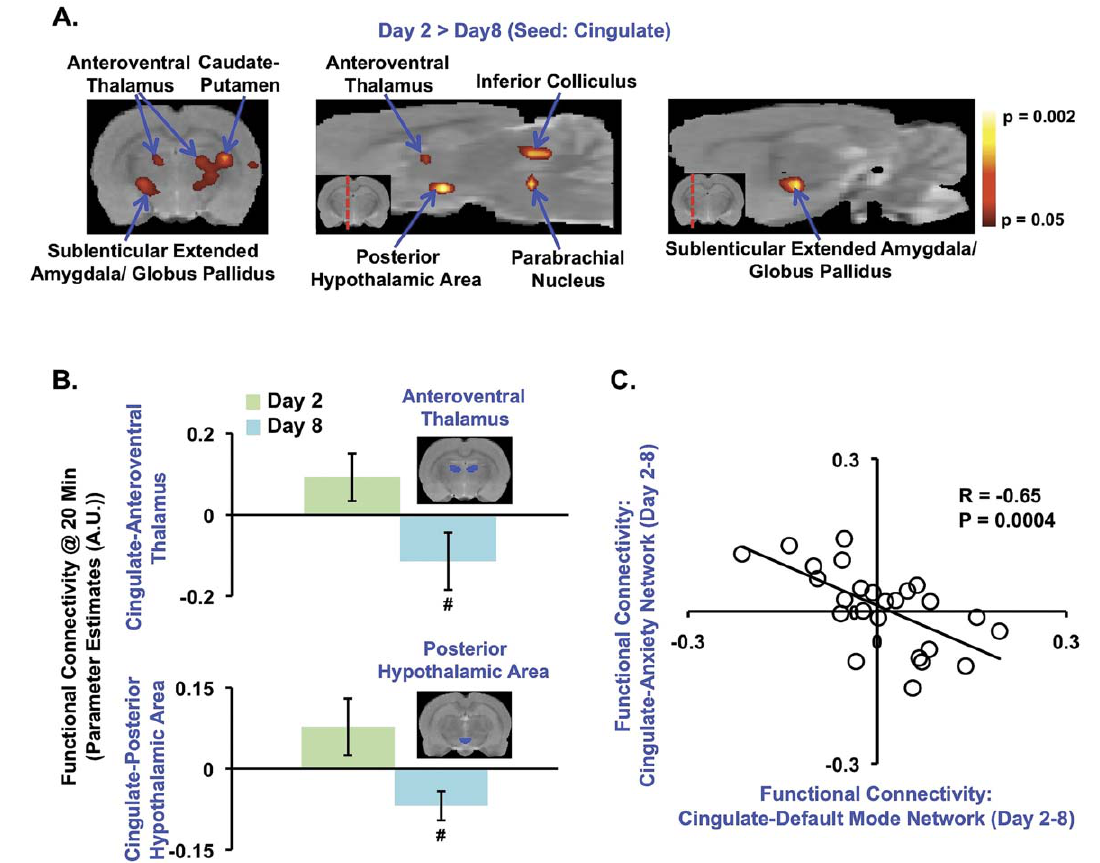
Figure 3. Functional Connectivity in the Anxiety Network in Non-habituated, Awake Rats. A-B. Functional connectivity amongst the anterior cingulate cortex and brain regions implicated in anxiety was significantly greater during the initial scanning session at Day 2. All statistical maps are superimposed upon an in-house, high-resolution rat anatomical template. B. Functional connectivity at Day 2 and Day 8 is quantified between the cingulate and anteroventral thalamus, and also with the posterior hypothalamic area. The ANOVA test yielded insignificant results for the cingulate-anteroventral thalamus (F 3,22 =2.49, p=0.087) and cingulate-posterior hypothalamic area (F 3,22 =1.37, p=0.27) functional interactions. Two-tailed, t-test did reveal significant differences particularly between Day 2 and Day 8 (cingulate-anteroventral thalamus- Day 4 : t 10 =1.91, p=0.09; Day 6 : t 12 =1.31, p=0.22; Day 8 : t 12 =2.26, p=0.043). (cingulate-posterior hypothalamic area- Day 4 : t 10 =1.07, p=0.30; Day 6 : t 12 =0.52, p=0.61; Day 8 : t 12 =2.74, p=0.018). All error bars represent s.e.m. Day 2 (N=7); Day 4 (N=5); Day 6 (N=7); Day 8 (N=7). # p , 0.05 C. A significant inverse correlation was detected between the cingulate-default mode and cingulate-anxiety network structures. One statistical outlier (Z=3.76) was detected using Grubb’s test for outlier detection, and not included in correlation analysis. For N=26, Z-critical = 2.84 (p ,